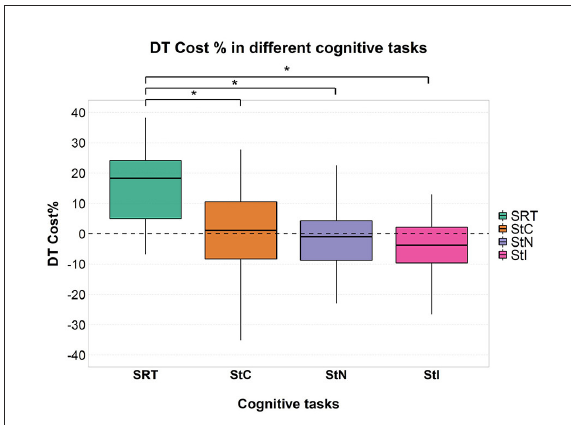
FIGURE1 Cognitive DTC in each cognitive task. A negative value means a reduced response time and a consequently better performance and vice versa. A dashed line to mark the zero was added. Significant pairwise comparisons are marked with an asterisk. SRT, Simple Reaction Time; StC, Congruent Stroop Test; StN, Neutral Stroop Test; StI, Incongruent Stroop Test.